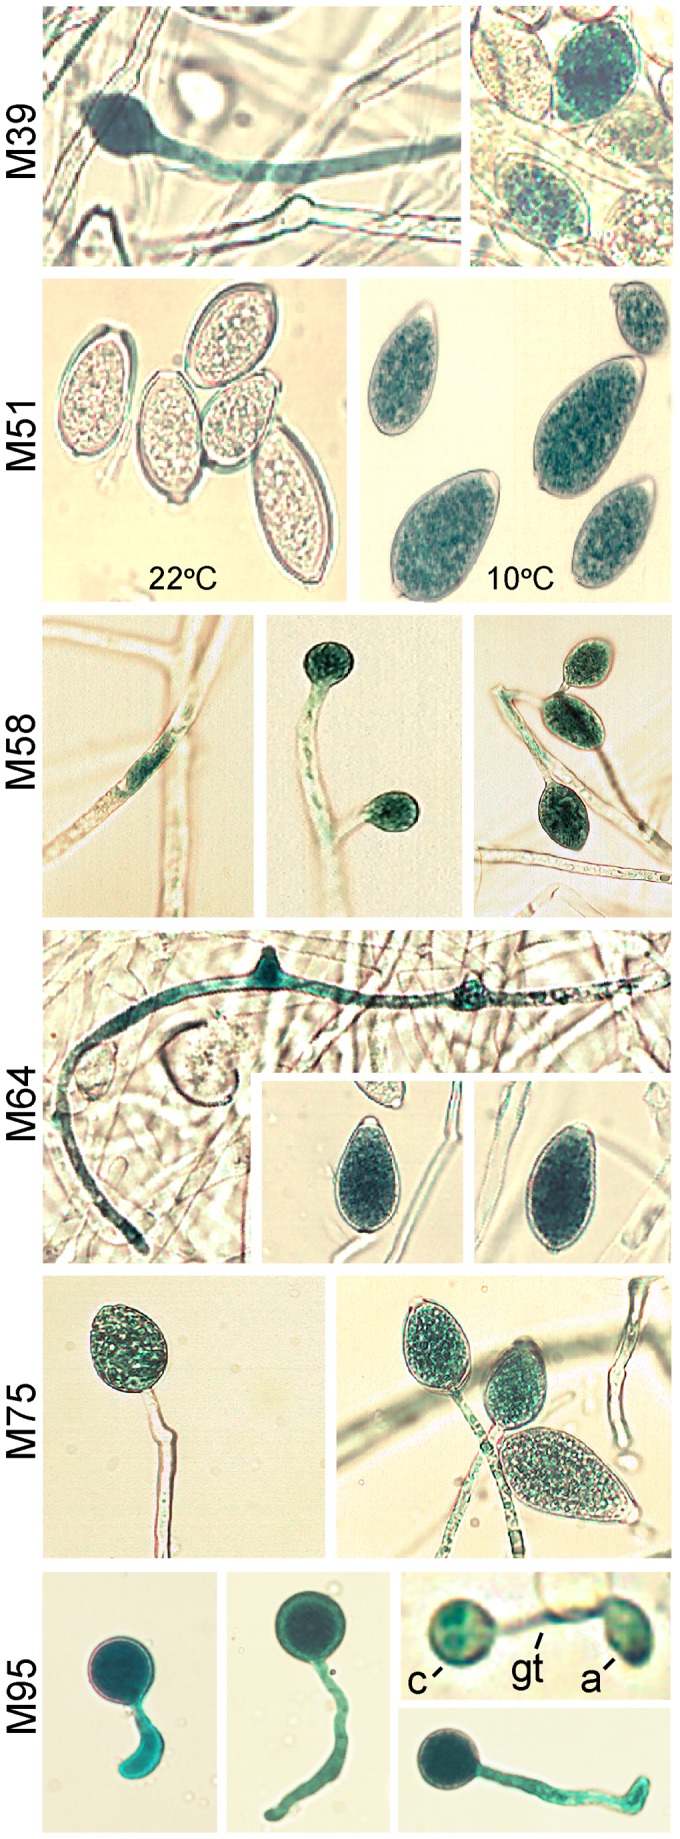
Histochemical staining of GUS under control of stage-specific motifs in stable transformants of P. infestans.For cleavage-associated motif M51, shown are the staining patterns of sporangia kept at 22°C or incubated at 10°C for 1-hr, in a representative transformant containing pDEL187. No staining was seen in hyphae. Similar patterns were seen in transformants in which M51 alone was fused to the NifS minimal promoter (not shown). For the other motifs, the transformants contained fusions of the motifs to the minimal promoter, and the images presented illustrated when GUS expression was first detected. These were at early and late stages of sporulation (M39, M58, M64, M75) or in germinated cysts (M95). Labeled in the M95 panel are the cyst (c), germ tube (gt), and appressorium (a).